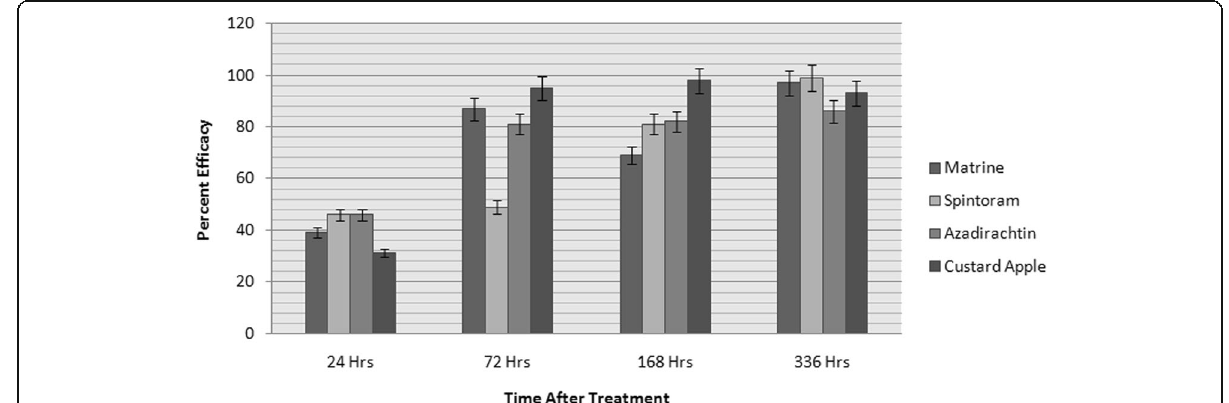
Fig. 1 Comparative efficacy of biopesticides against Tetranychus urticae Koch and Aphis gossypii